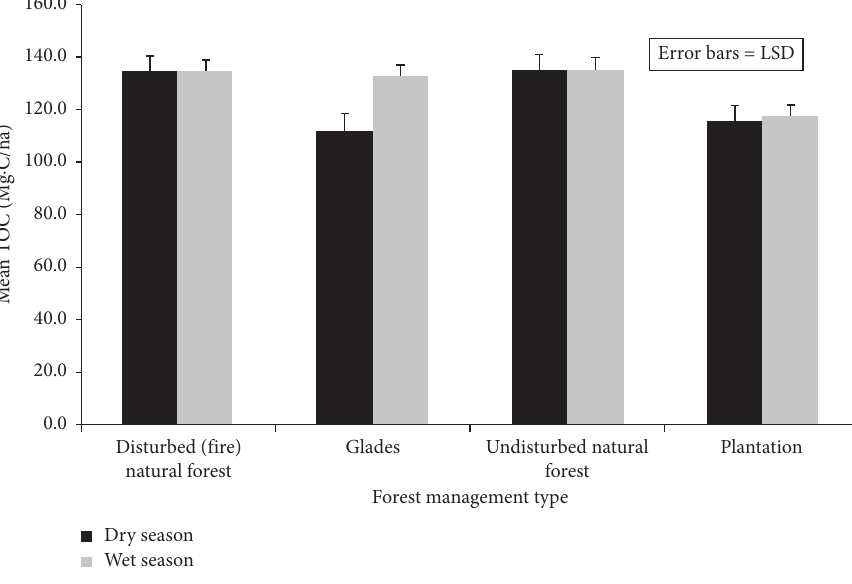
Figure 3: Effects of seasonal weather variations on soil carbon stocks.